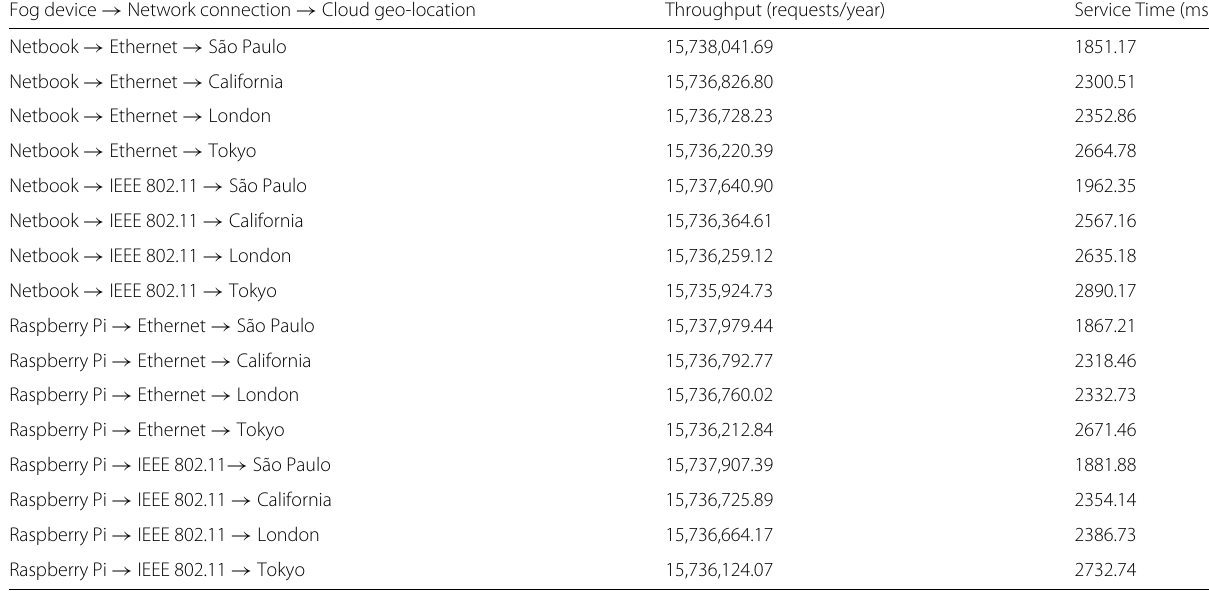
Table 9 Performance results of scenario